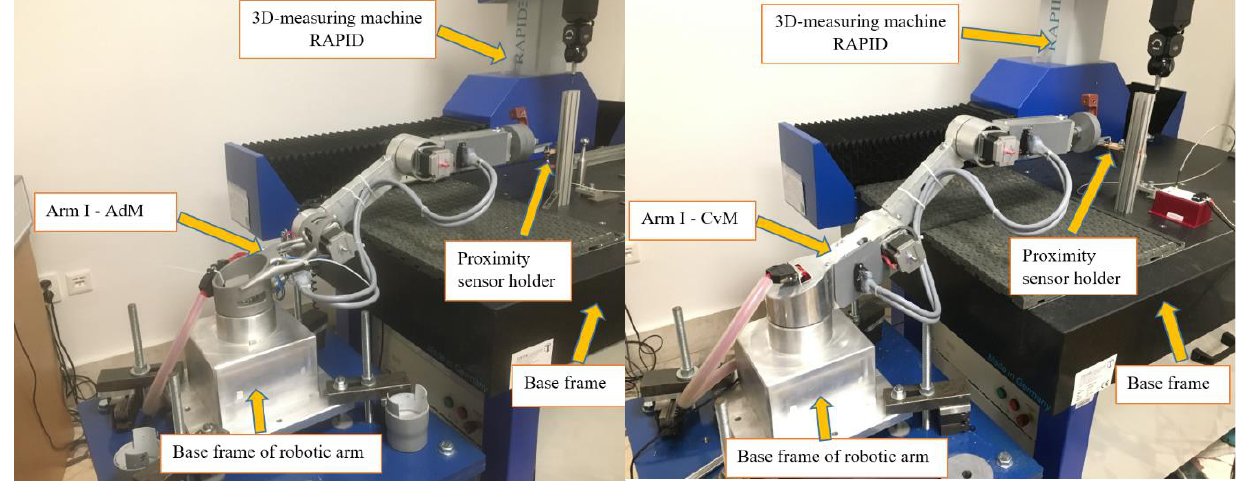
Figure 8. NcM of robotic arm’s position deviation with Arm I — AdM and Arm I — CvM.